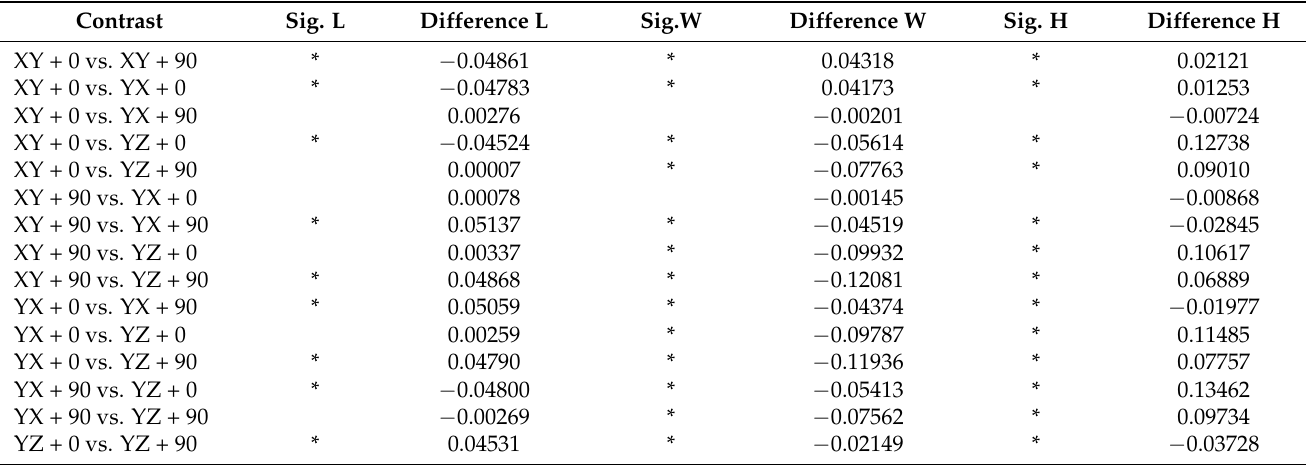
Table 8. Dimension deformation showing significant differences between internal geometries (* denotes a statistically significant difference).